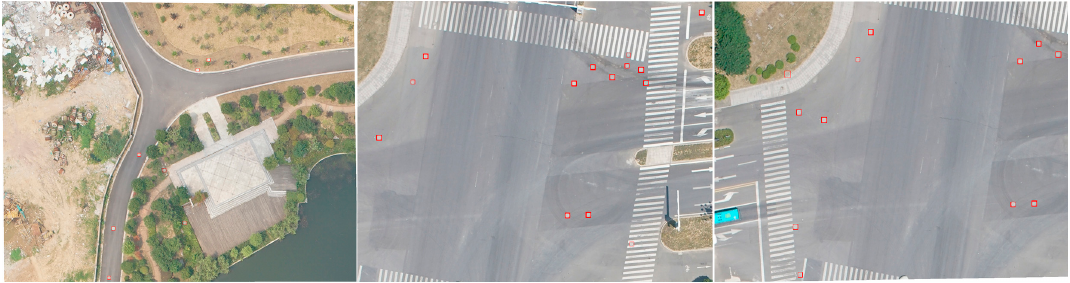
Figure 6. Manhole cover detection results with the proposed approach on three images.